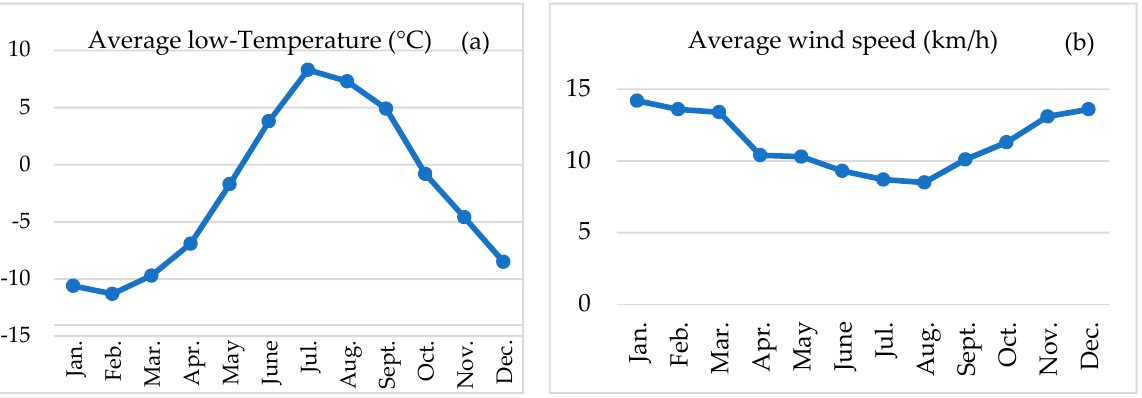
Figure 9. Monthly average temperatures ( a ) and wind speeds ( b ) at the WF’s location [54]. Data were gathered from Weather Atlas.